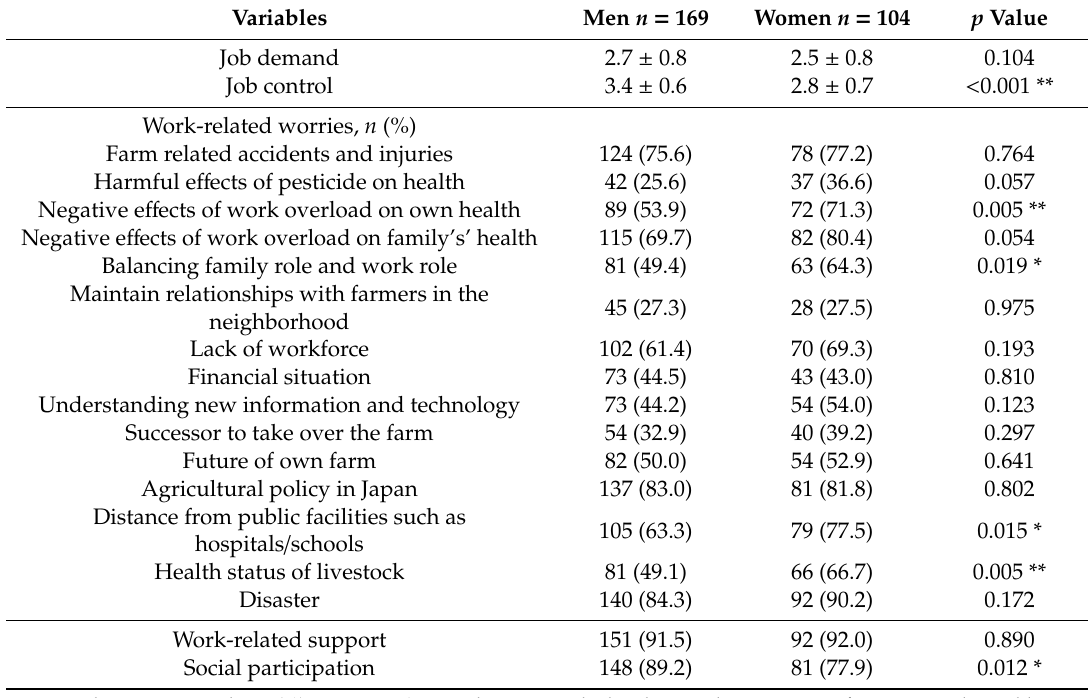
Table 3. Description of work environment characteristics by